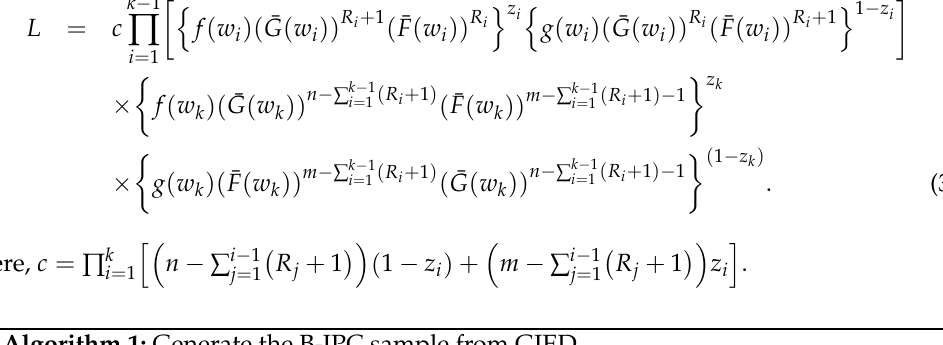
Algorithm 1: Generate the B-JPC sample from